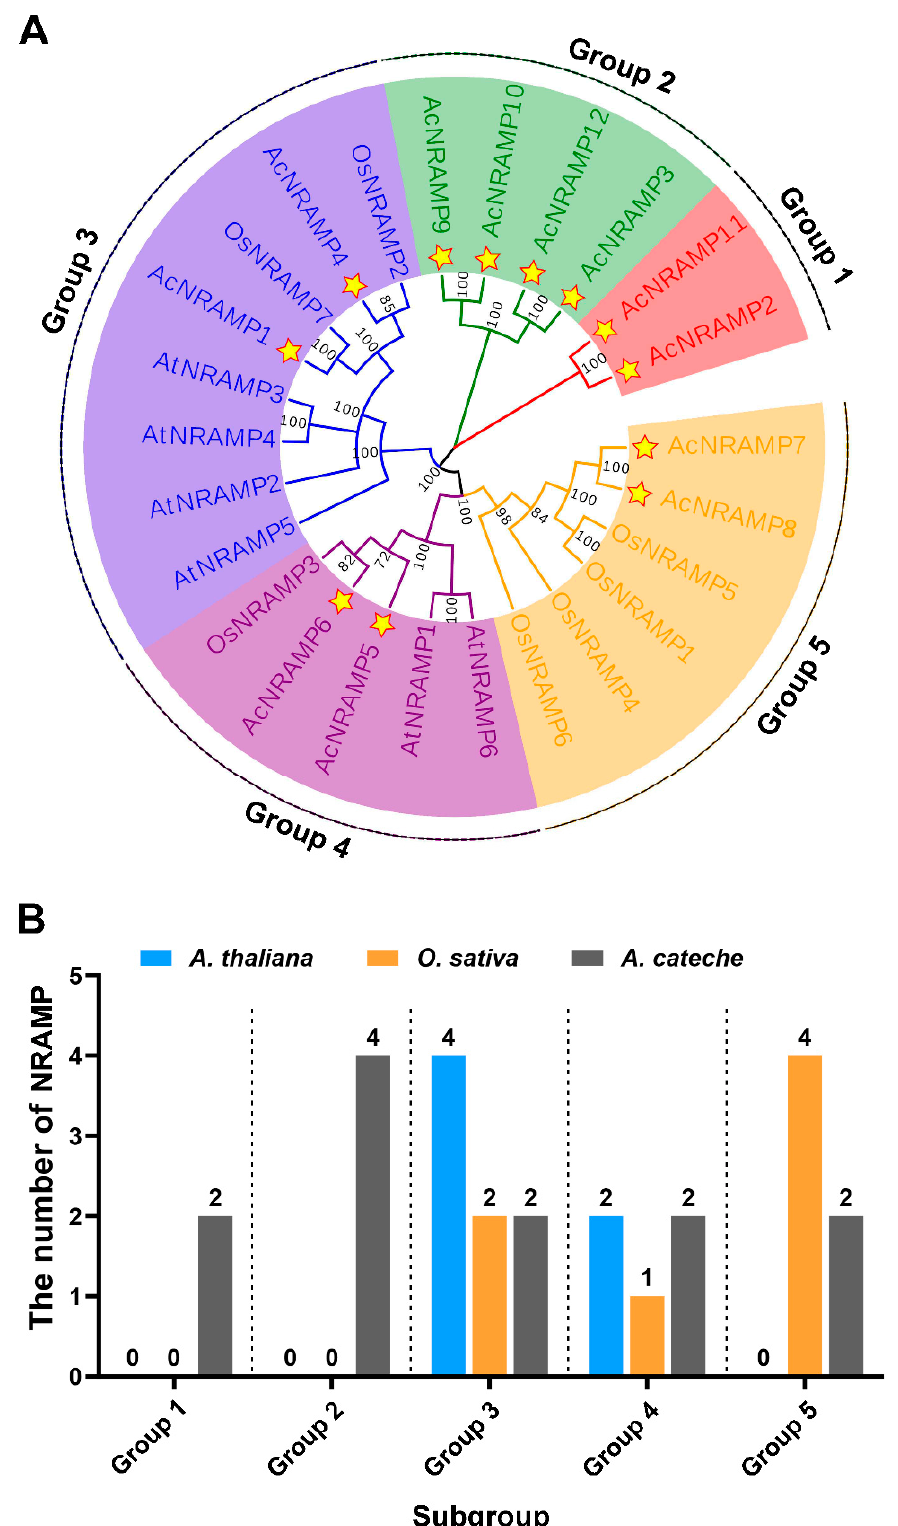
Figure 4. Phylogenetic relationships of NRAMP proteins in A. catechu , O. sativa , and A. thaliana . ( A ) The phylogenetic tree has 25 NRAMP proteins, including 12 AcNRAMP, 7 OsNRAMP, and 6 AtNRAMP). Star-marked 12 NRAMP genes of A. catechu . ( B ) The number of AcNRAMPs, Os- NRAMP, and AtNRAMP in the different